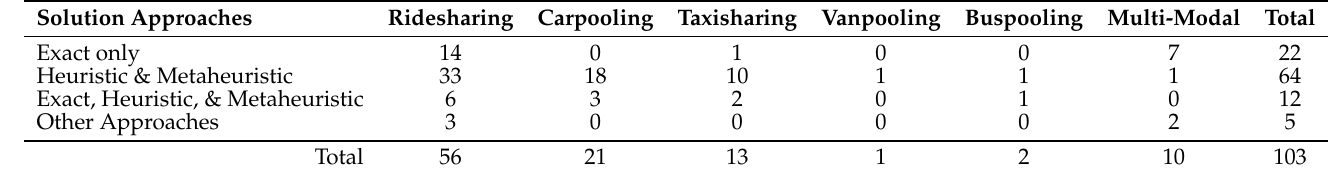
Table 8. Distribution of Papers based on the Solution Approaches Solution